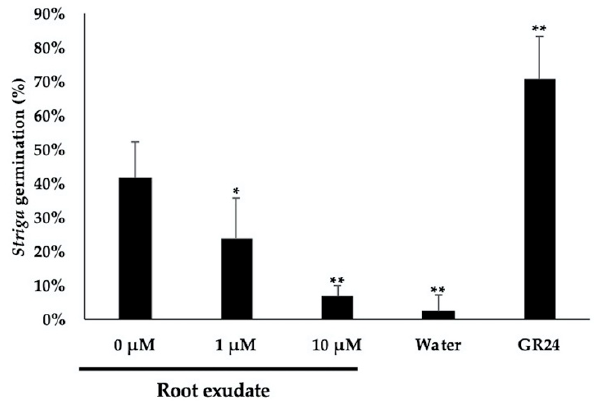
Figure 6. Germination of Striga seeds in the culture media of root exudates from untreated rice (0 μ M triflumizole) and rice treated with 1 and 10 µ M triflumizole. GR24 (synthetic SL analog) and sterile water were used as positive and negative controls, respectively. The data are expressed as mean ± SD of five samples. Statistically different from the germination percentage of 0 μ M triflumizole ((*) = t test; 0.01 < p < 0.05, (**) = t test; p < 0.01).